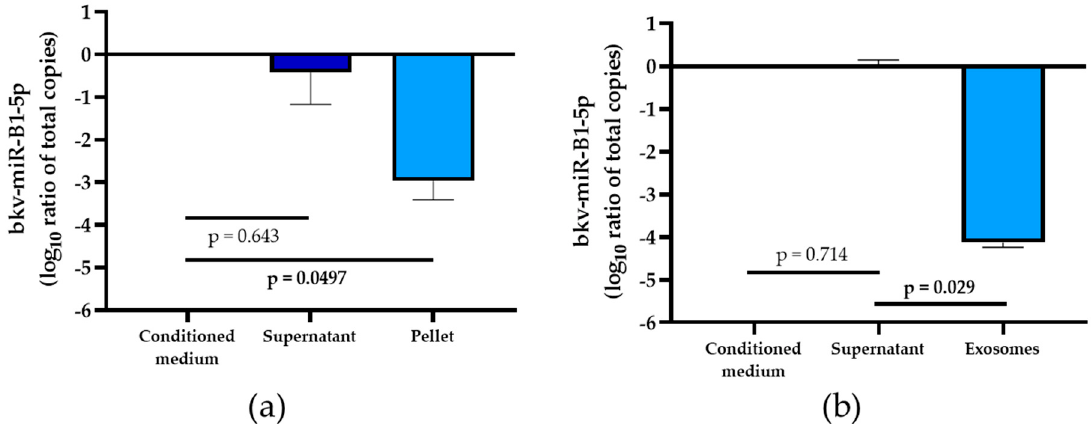
Figure 3. Log10 ratio of total bkv-miR-B1-5p amounts in the extracellular environment of BKPyV- infected Vero cells. Colored bars represent mean, and error bars represent the standard deviation of 3 independent experiments. p values were obtained by a Mann–Whitney test for both ( a ) and ( b ) experiments. ( a ) Log10 ratio of total bkv-miR-B1-5p amount in conditioned medium, supernatant and pellet resulting from a 100,000× g ultracentrifugation for 2 h at 4 °C; ( b ) Log10 ratio of total bkv-miR-B1-5p amount in conditioned medium, supernatant and exosome eluate resulting from μ MACS Exosome Isolation Kit Pan, human (Miltenyi ® ).